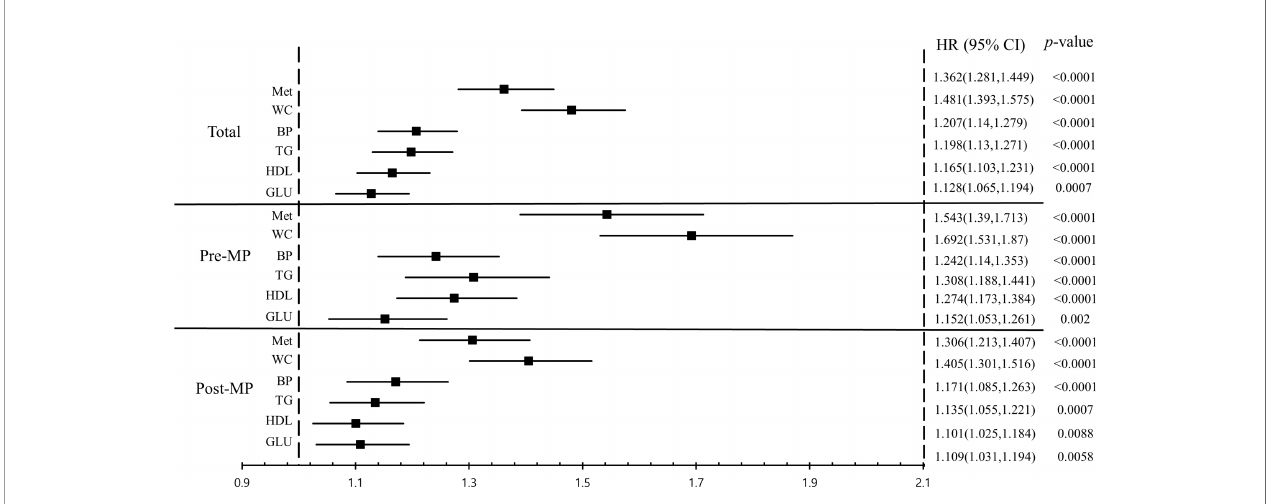
FIGURE 2 | Association of metabolic syndrome and its components and incidence of endometrial cancer among all women, pre-menopausal women, and post- menopausal women. Age, sex, smoking, alcohol consumption, and regular exercise were adjusted. BP, blood pressure; CI, con fi dence interval; GLU, fasting blood glucose; HDL-C, high-density lipoprotein cholesterol; HR, hazard ratio; Met, metabolic syndrome; Post-MP, post-menopausal; Pre-MP, pre-menopausal; TG, triglycerides; WC, waist